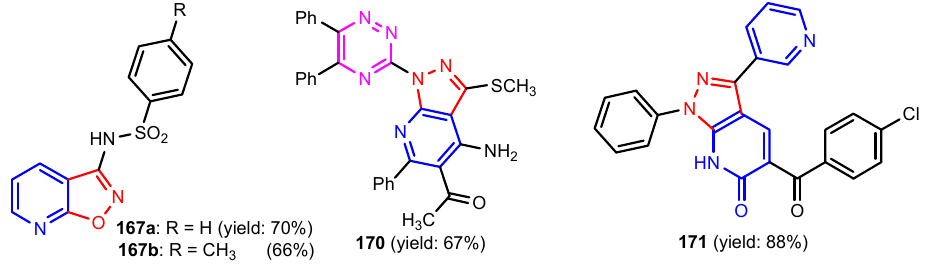
Figure 17. Structures of compounds 167a , 167b , 170 , and 171 [71,73,74].